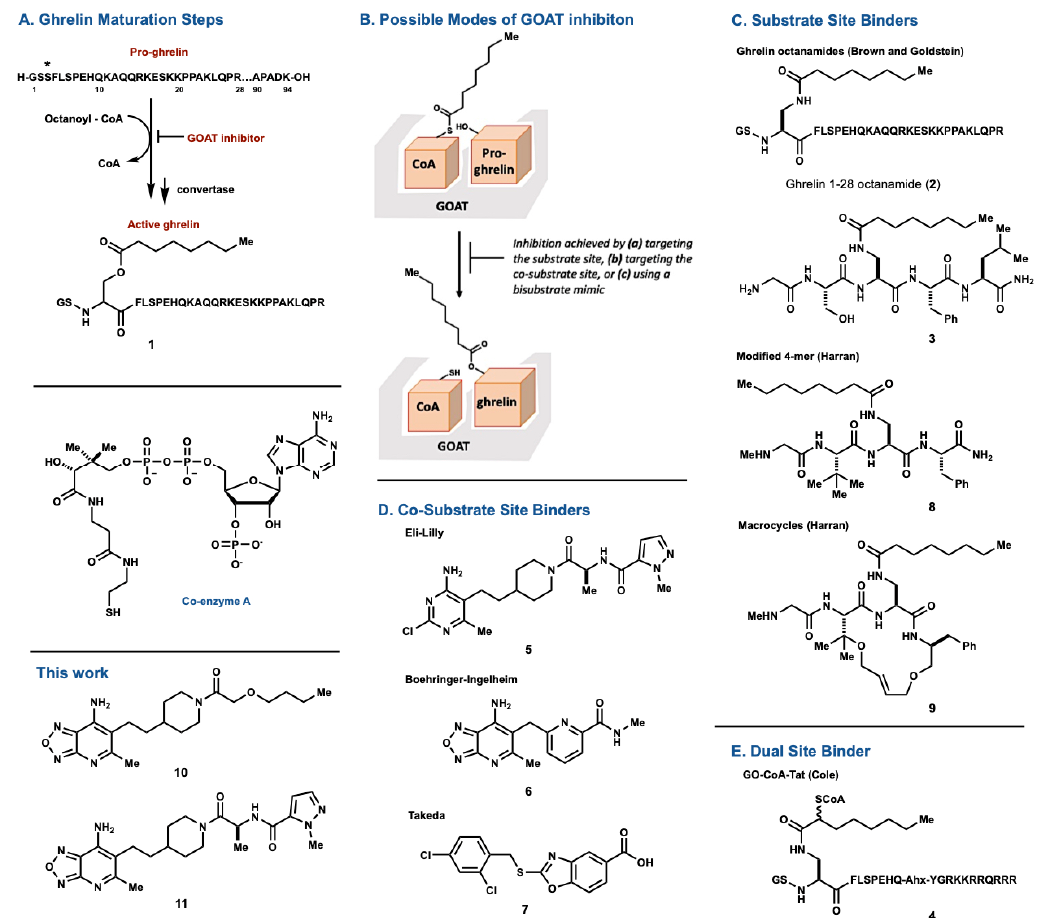
Figure 1. ( A ) GOAT-catalyzed octanoylation of pro-ghrelin is a critical part of ghrelin maturation. GOAT is weakly inhibited by its reaction product, acyl ghrelin ( 1 ), and more potently by analog 2 , wherein Ser-3 is replaced by diaminopropionic acid (DAP). Systemic inhibition of GOAT is expected to reduce circulating acyl-ghrelin levels, leading to improved insulin response to glucose challenge. ( B ) GOAT inhibition can be achieved by targeting either the substrate or co-substrate site, or by targeting both sites with a “bisubstrate” mimic. ( C – E ) Known inhibitors of GOAT.